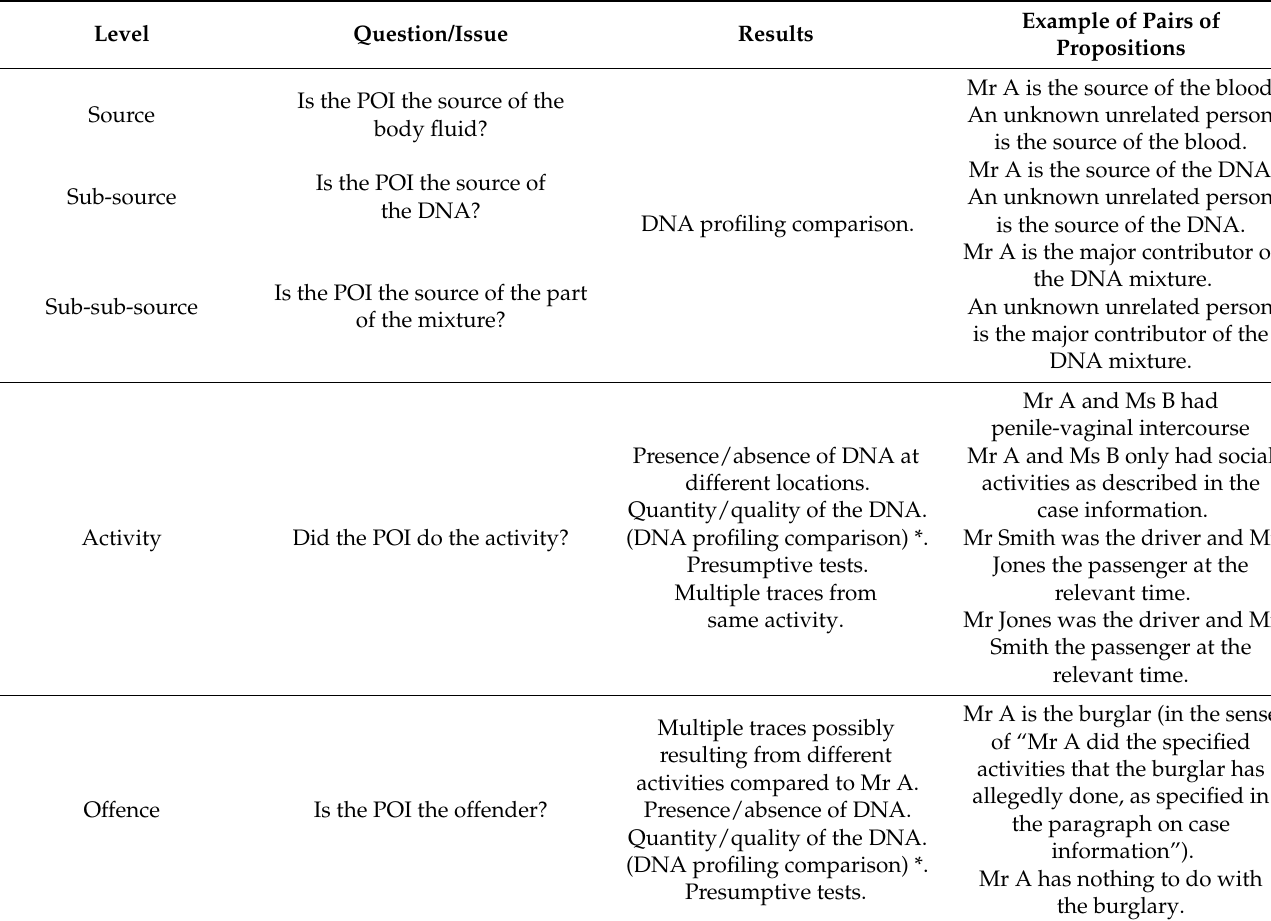
Table 4. Evaluative examples of pairs of mutually exclusive propositions at different levels in the hierarchy that DNA scientists could contribute to addressing provided they have knowledge that is needed but which otherwise would be unavailable to the